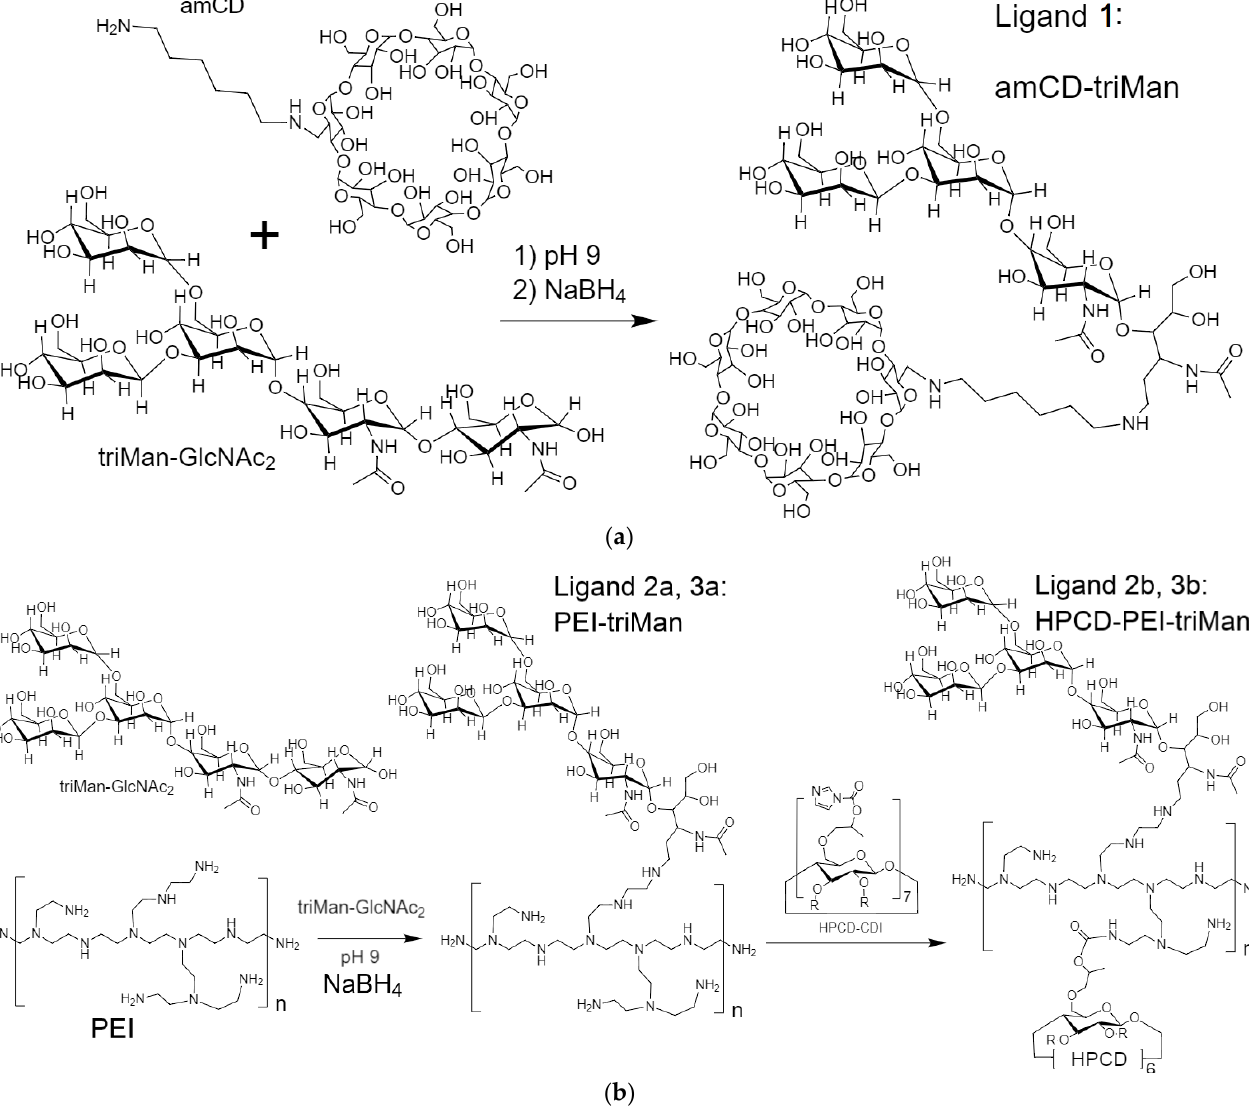
Figure 1. Scheme of synthesis of mannosylated conjugates: ( a ) amCD-triMan; ( b ) PEI1.8-triMan or PEI10-triMan and HPCD-PEI1.8-triMan or HPCD-PEI10-triMan. For PEI 1.8 kDa, n is in the range 3 – 5; for PEI 10 kDa, n is in the range 20 – 25.